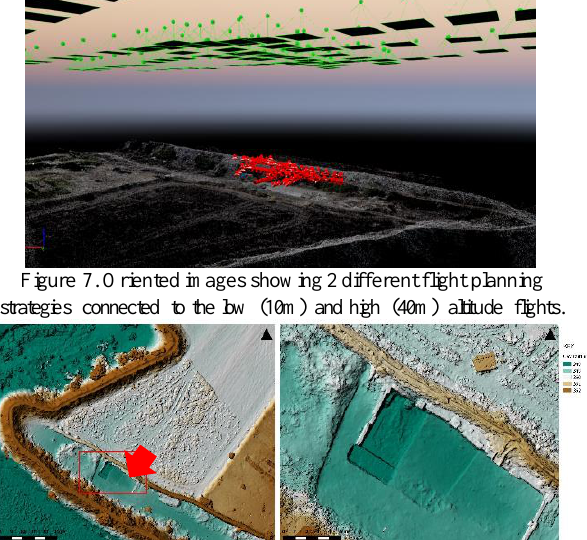
Figure 8. The impressive limestone channels, which flows sinuously north away from the city in the 0.017 m resolution DSM (left); the excavated basin in the high resolution DSM (right).